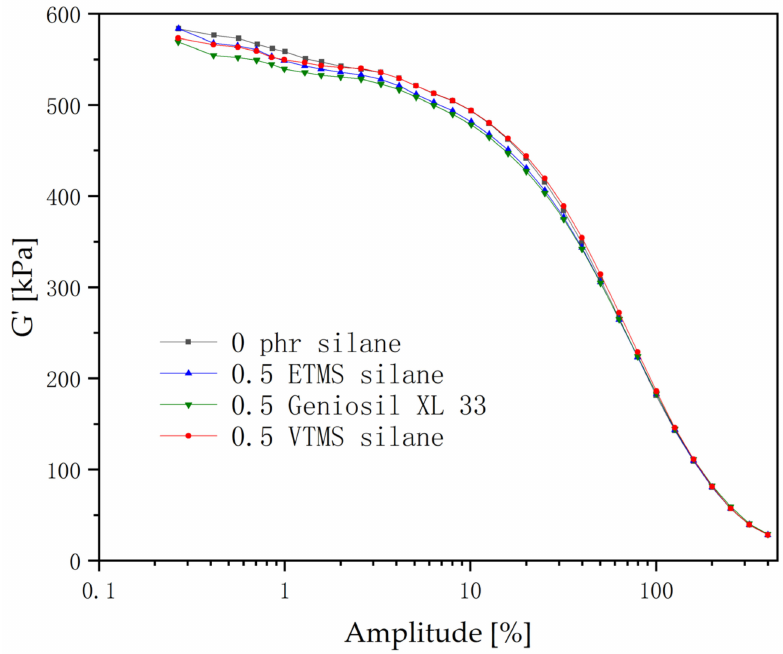
Figure 2. Relationship between the shear modulus and strain of EPDM/CaCO 3 compounds.